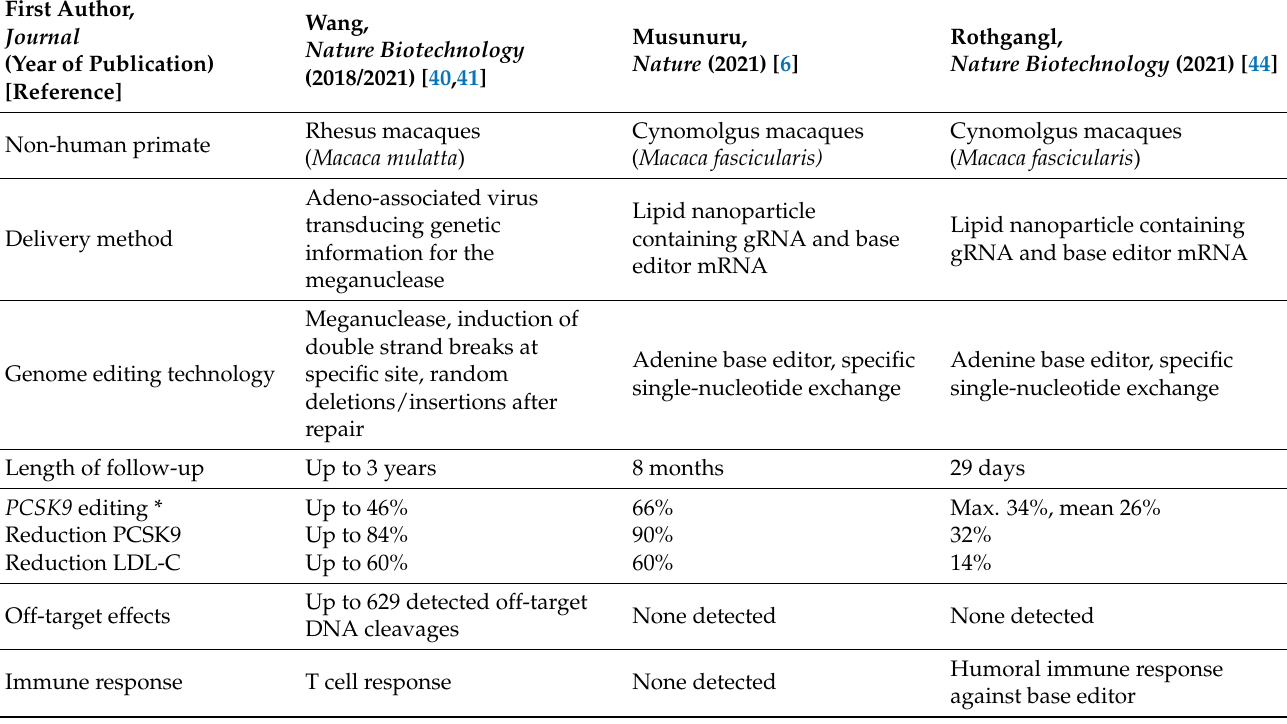
Table 1. Comparison of studies on PCSK9 editing in non-human